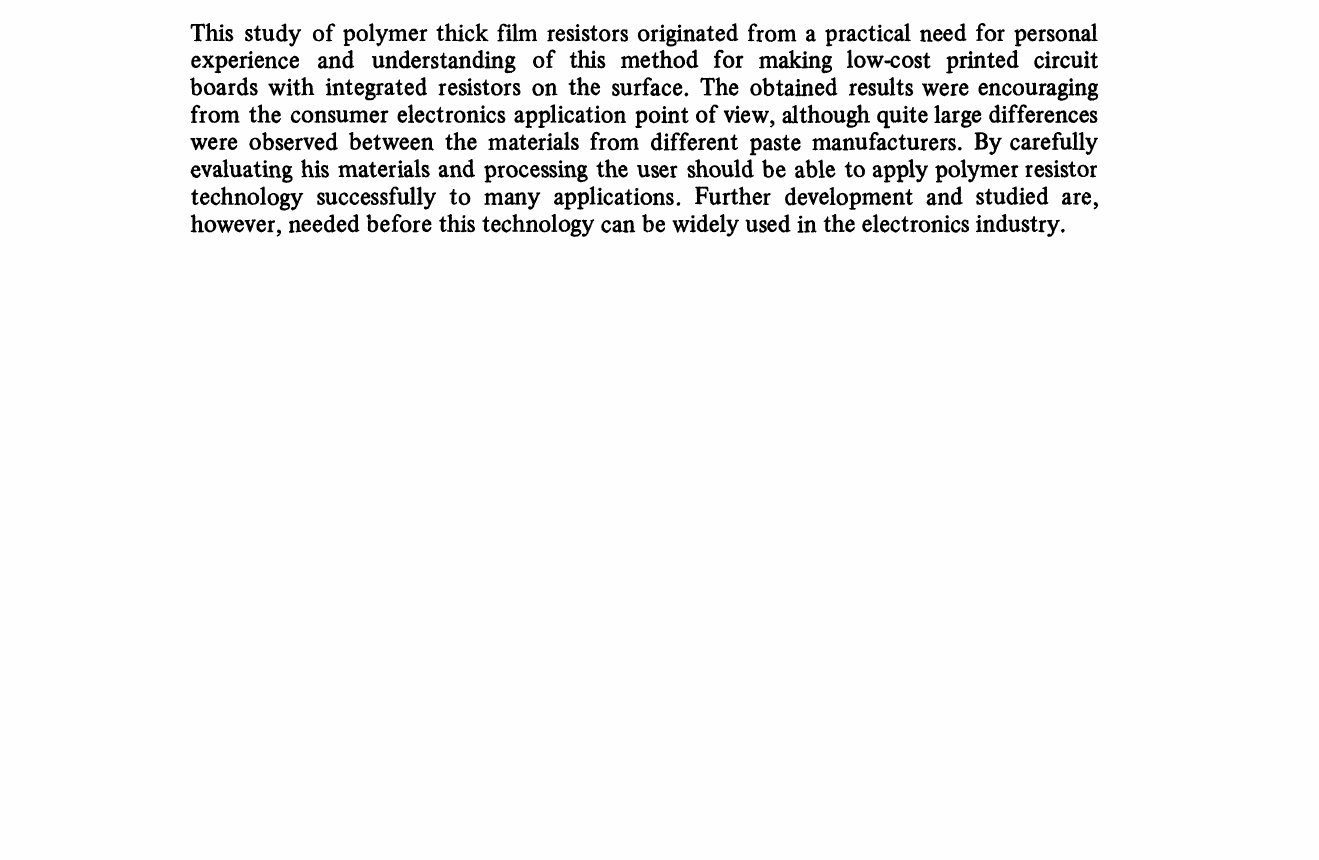
FIGURE 6 DTA-curves of the studied polymer resistor materials (temperature rise